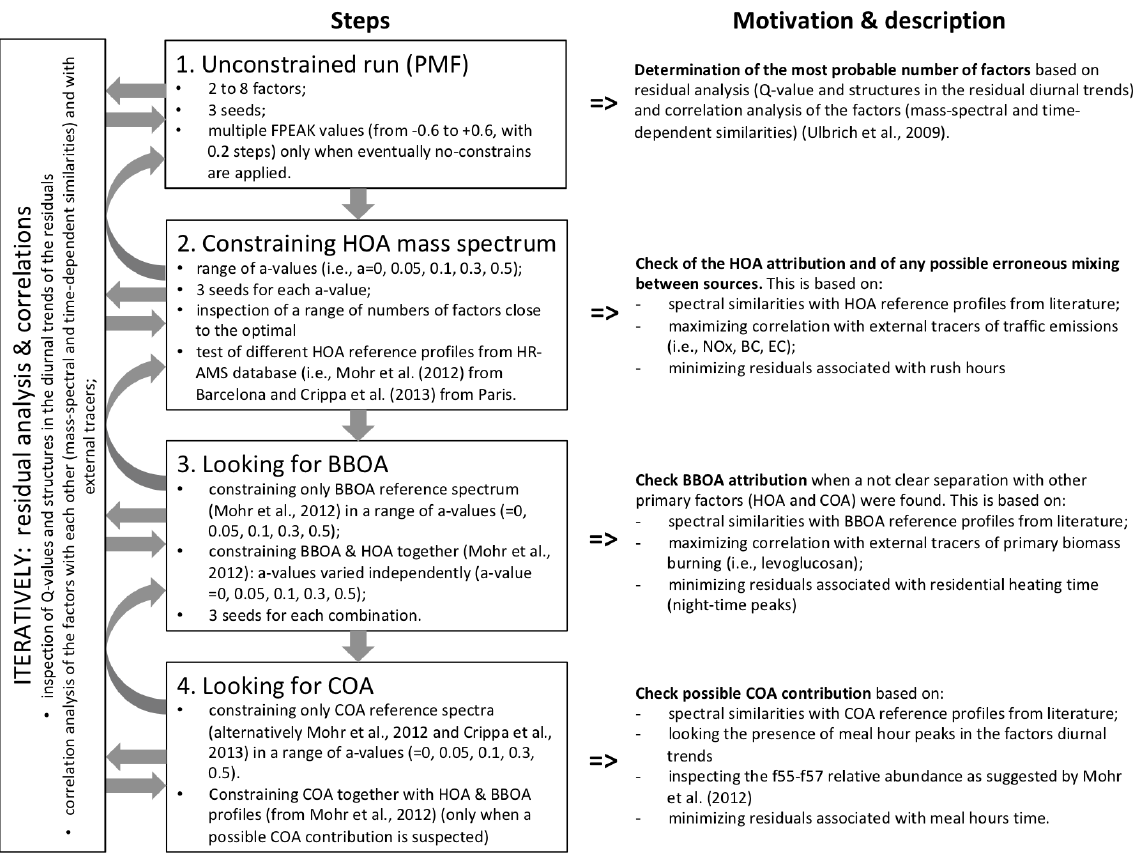
Figure 2. Schematic step-by-step procedure of the adopted source apportionment approach.